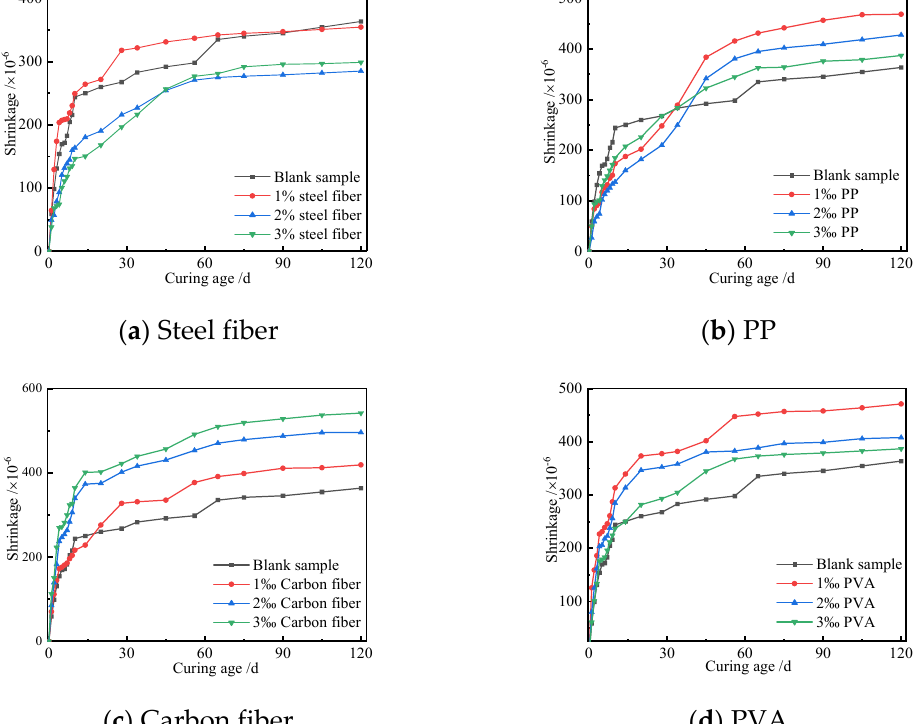
Figure 11. Shrinkage curves of the UHPC with different fibers and curing ages.